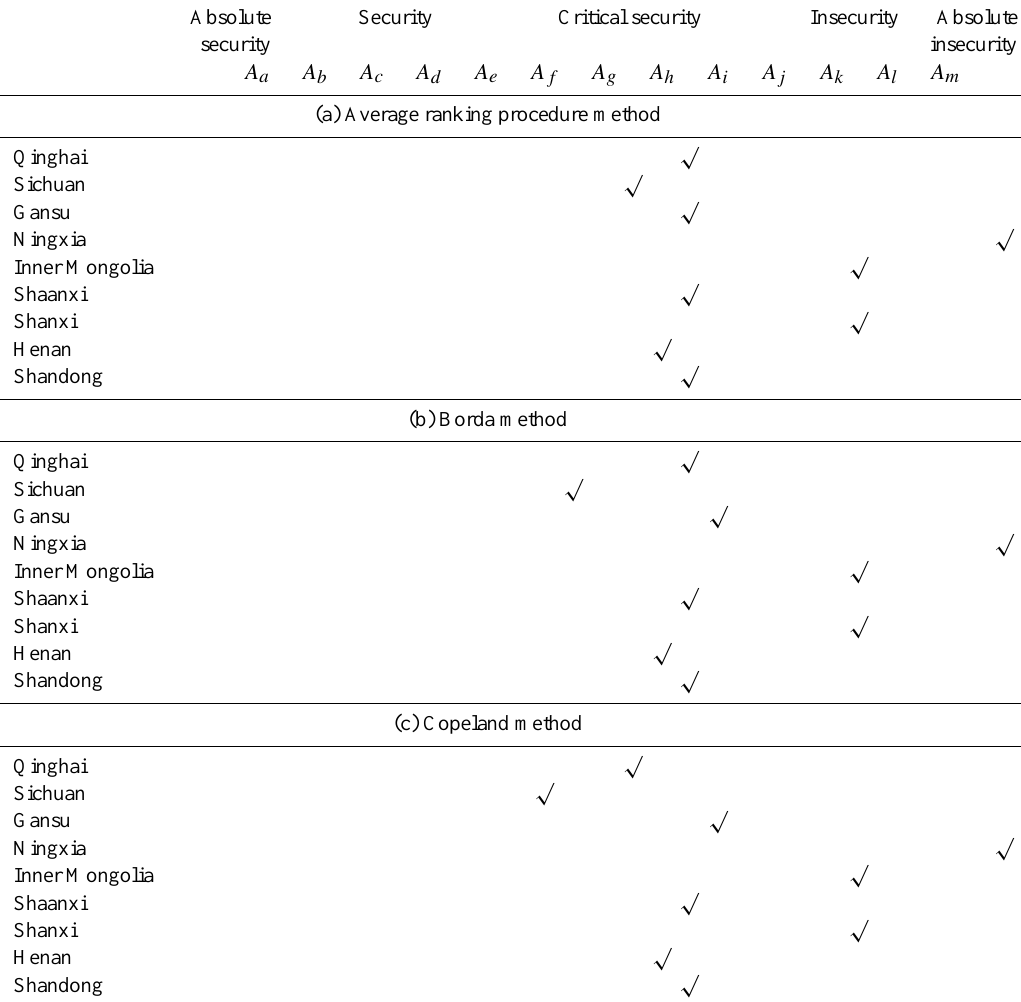
Table 9. Evaluation level of water resources security by three MADM aggregation methods in nine provinces in 2006.